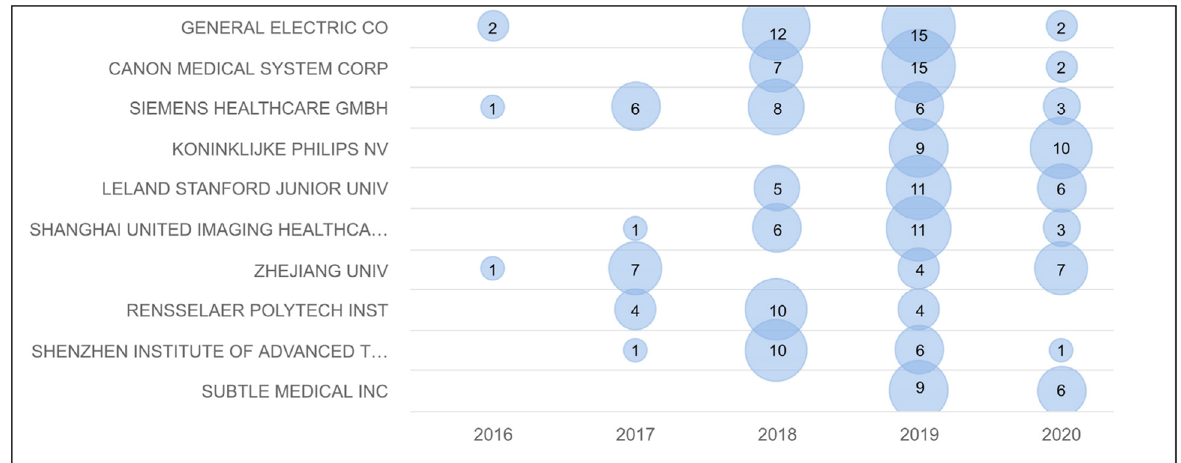
Fig. 4 Innovation timeline by original assignee vs application date, where innovation intensity is shown by the number of assigned patent applications per assignee per year